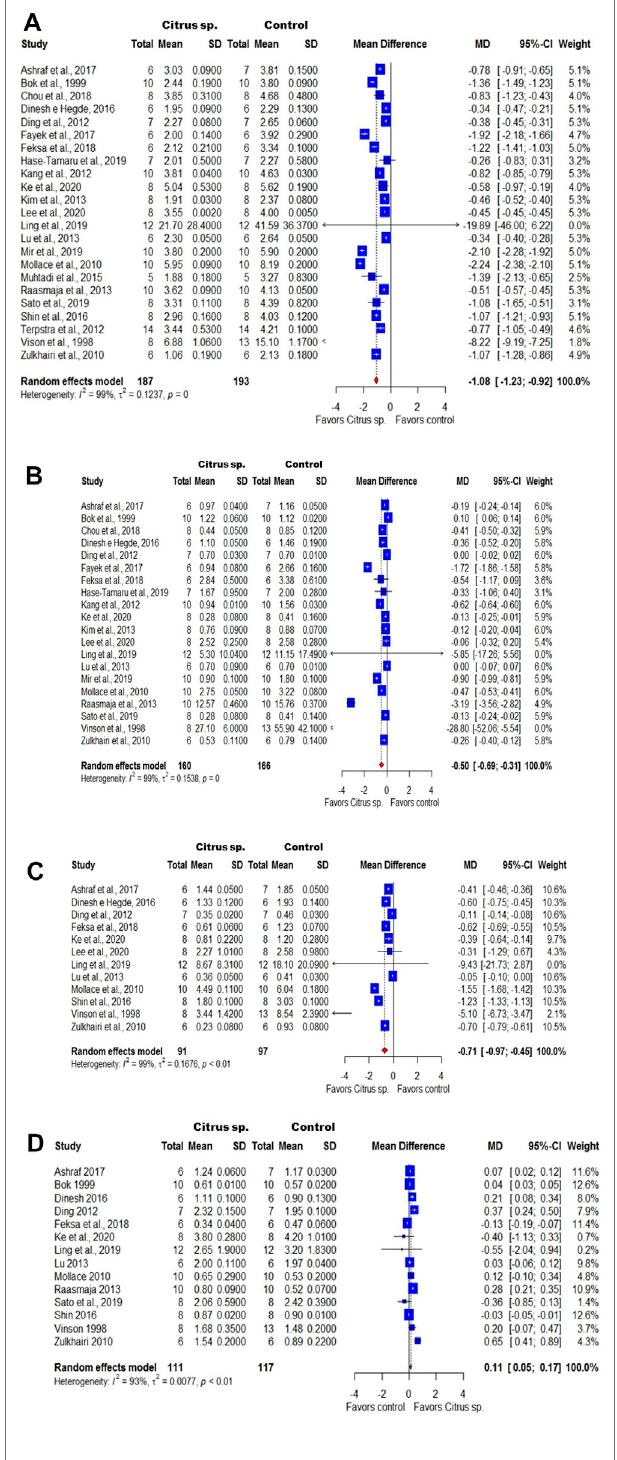
FIGURE4 | Forest plot ofthe preclinical studies that evaluated the effect of Citrus species on total cholesterol (A) , triglycerides (B) , LDL (C) , and HDL (D) levels. The numbers on the x -axis indicate the effect of the treatment and its favoring. SD: standard deviation of the differences. MD: difference between the